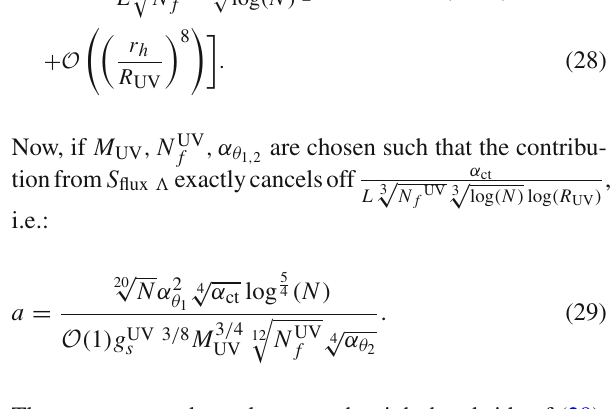
function [60]. 5 A very good global Chi-squared minimiza- tion fit which includes the high temperature lattice results is shown on Fig. 2, and produces